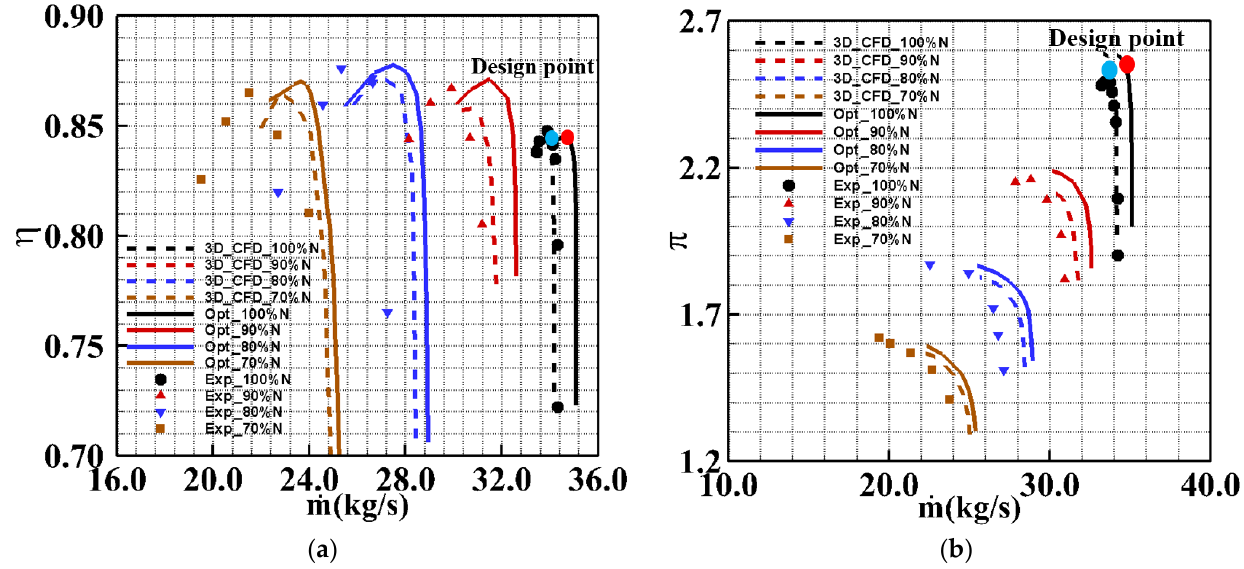
Figure 12. The comparison of the aerodynamic performance curves for a two-stage fan at different speeds. ( a ) Flow mass rate vs. adiabatic efficiency; ( b ) Flow mass rate vs. total pressure ratio.